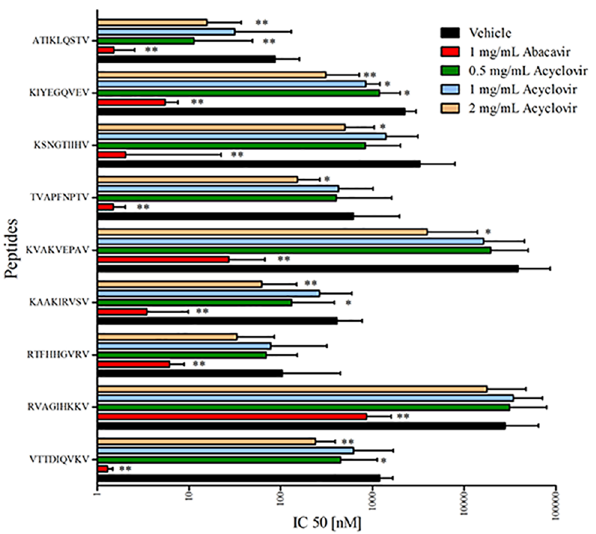
Fig 3. Effects of abacavir and acyclovir on HLA-B * 57:01 binding specificity. Specific peptides with a terminal valine that showed an increased affinity for HLA-B * 57:01 in the presence of abacavir were tested. Values are represented as geometric mean with 95% CI of two independent runs in triplicates, analyzed for statistical significance by Mann-Whitney U test comparing log IC 50 values vs. vehicle; p < 0.05 was considered significant ( * p < 0.05; ** p < 0.01; *** p <